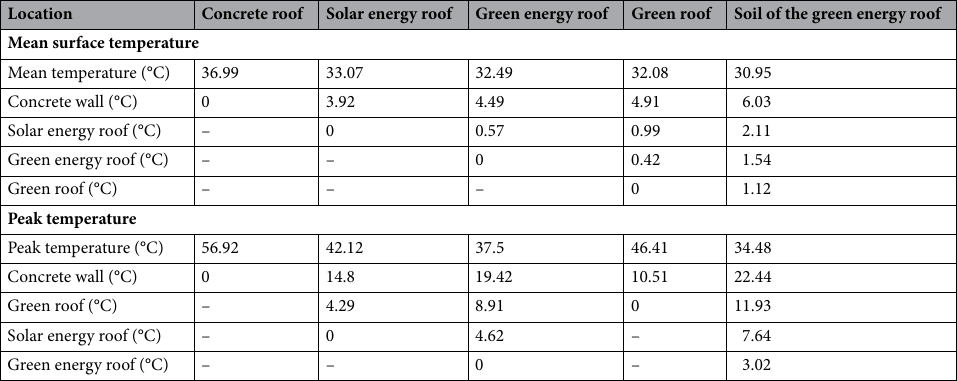
Table 9. Mean surface and peak temperatures.